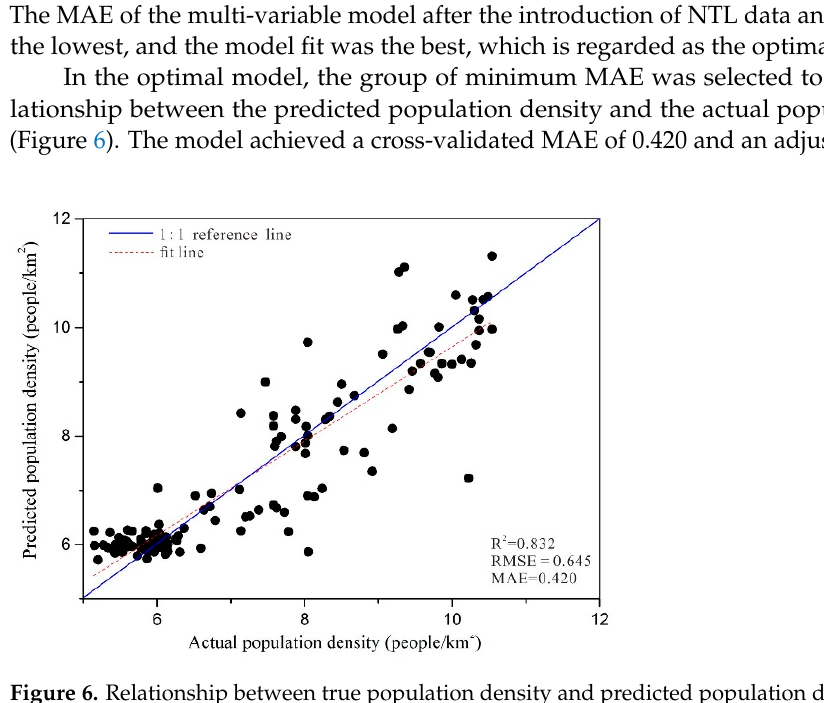
Figure 6. Relationship between true population density and predicted population density of optimal model (on a log scale). The data are from a group of multi-variable models with minimum MAE.